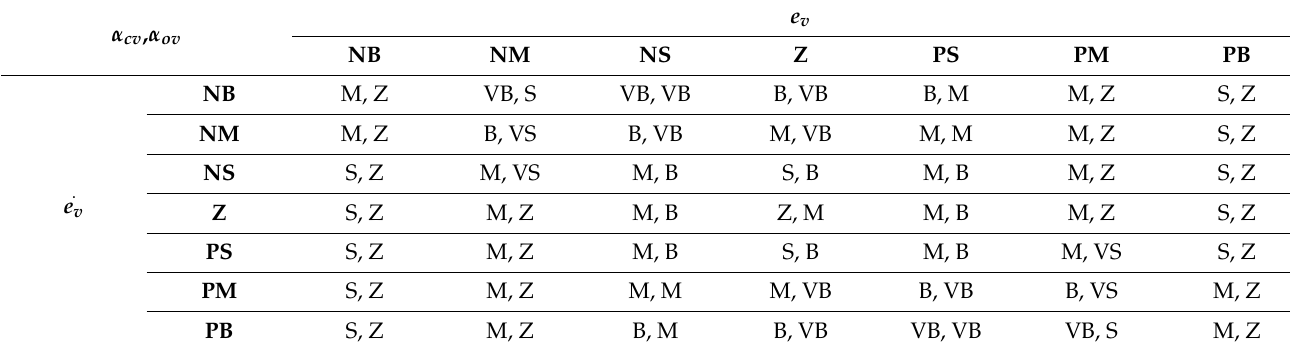
Table 1. Fuzzy rules base of speed controller.